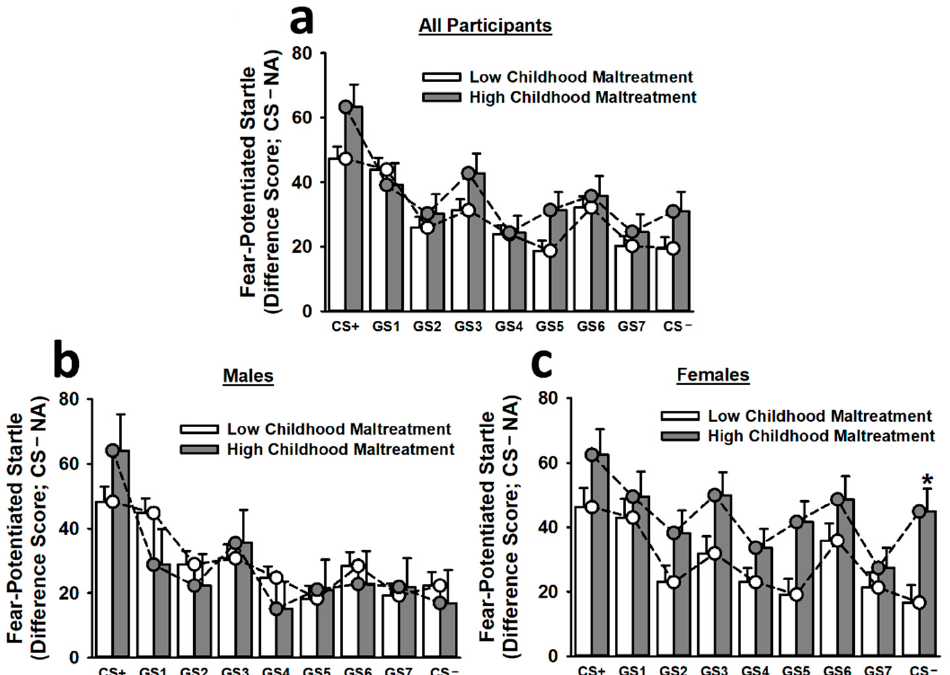
Figure 3. Fear-potentiated startle responses to the CS+, seven different GSs, and the CS − during the generalization phase on Day 2. The top figure inset ( a ) depicts fear-potentiated startle responses for all participants. Overall, participants exhibited a relatively smooth generalization gradient, with fear-potentiated startle responses being greatest to the CS+ and decreasing steadily as stimuli approached the CS − . No significant effect of childhood maltreatment on fear-potentiated startle responses was observed for males ( b ). Females reporting high childhood maltreatment demonstrated significantly greater fear-potentiated startle responses to the CS − than females reporting low child- hood maltreatment ( c ). Moreover, females reporting high childhood maltreatment appeared to exhibit greater fear generalization, as, in contrast to all other groups, these participants displayed statistically equivalent fear-potentiated startle responses to the CS+, GS1, GS2, GS3, GS5, GS6, and CS − . Data are means ± SEM. * p < 0.001 relative to low childhood